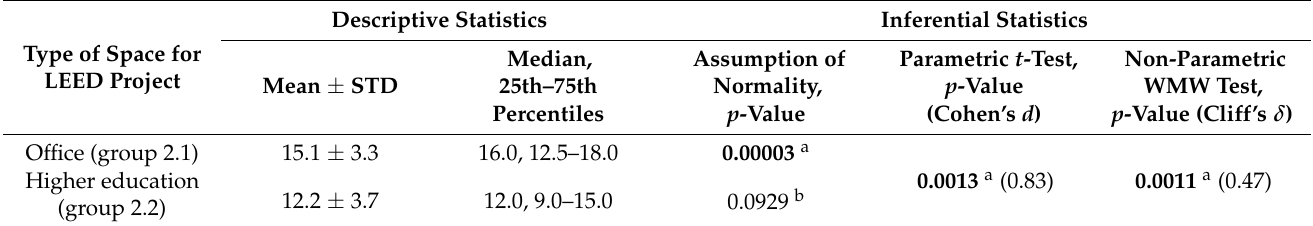
Table 5. Case 2: comparisons of EAc7 (Optimize Energy Performance) credit achievement for groups 2.1 and 2.2 without considering project size in LEED-NC v4 gold projects.